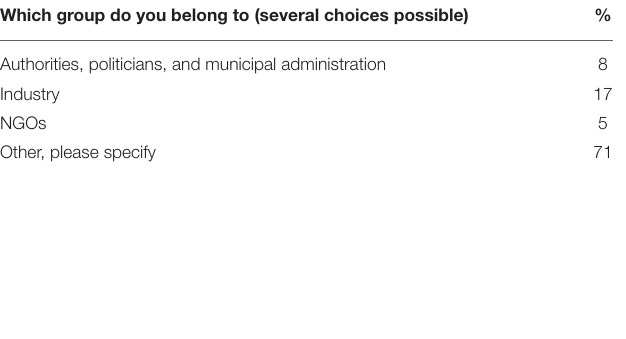
TABLE A2 | Survey respondents’ group